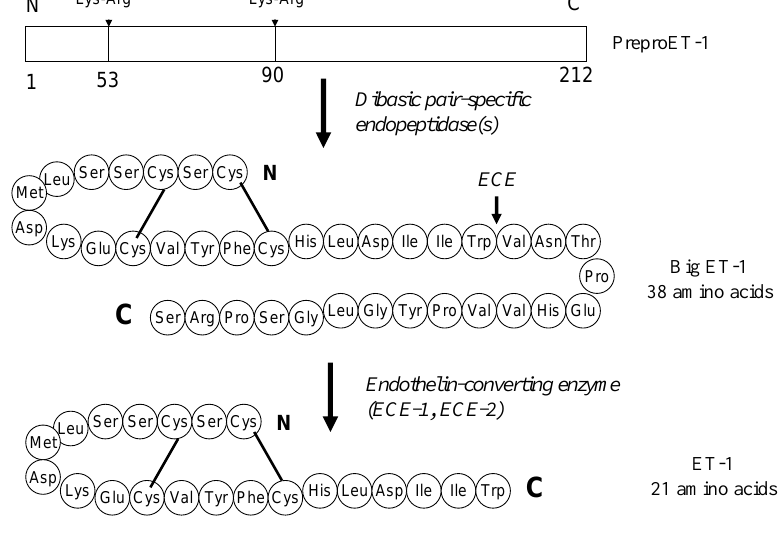
FIGURE 1. The biosynthesis and processing of